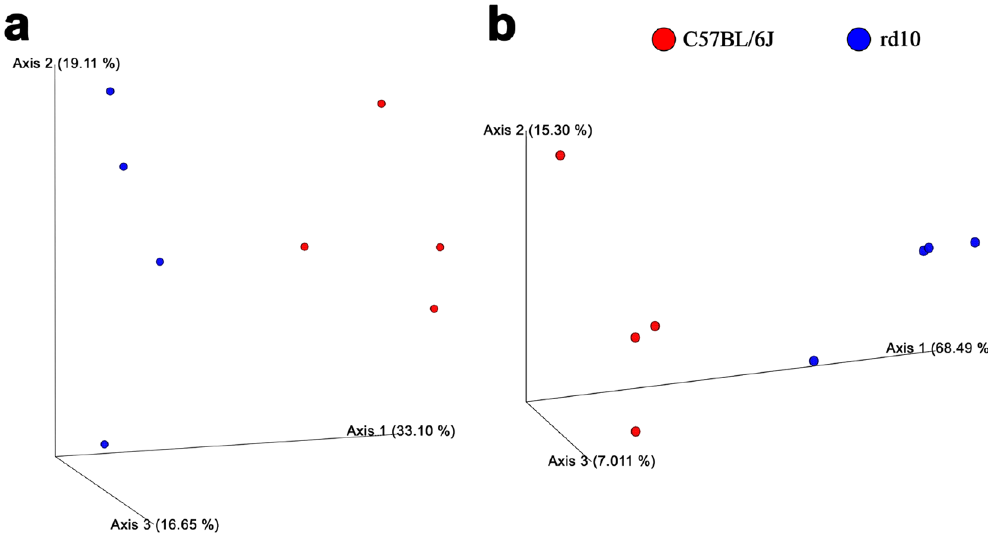
Figure 4. PCoA representation. ( a ) Principal coordinate analysis (PCoA) at species level, where C57BL/6J (red) and rd10 (blue) groups could be differentiated. ( b ) PCoA representing unweighted UniFrac distance for C57/6J (red) and rd10 (blue) mice gut were the two groups are separated from each other. The PERMANOVA test performed showed significant differences between the two groups.